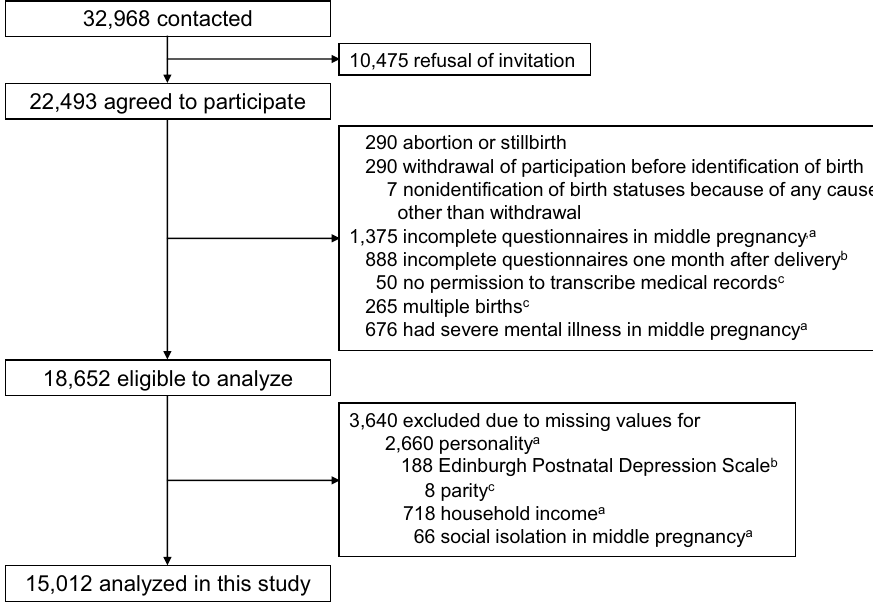
Figure 1. Flow diagram for the study participants in the present analysis of the Tohoku Medical Megabank Project Birth and Three-Generation Cohort Study. a Data on personality, household income, and social isolation were obtained using questionnaires administered in middle pregnancy. b Data on the Edinburgh Postnatal Depression Scale were obtained using questionnaires administered one month after delivery. c Data on multiple births and parity were obtained transcribing medical records from obstetric clinics or